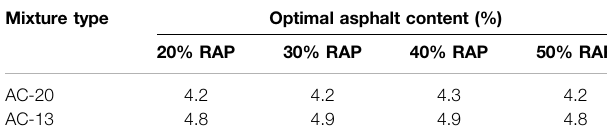
TABLE 5 | Summary results of the OAC for each asphalt recycled